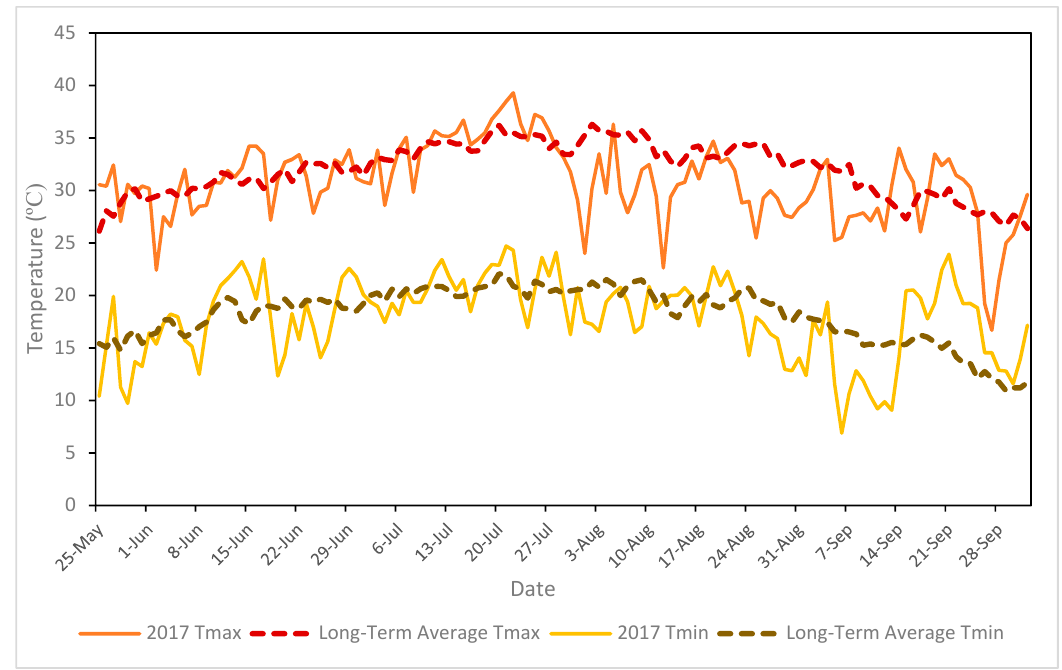
Figure 2. Daily temperature recorded during the summer growing season of 2017 and long-term averages (1998–2017) at El Reno, OK. Tmax and Tmin indicate the daily maximum and daily minimum temperatures, respectively.